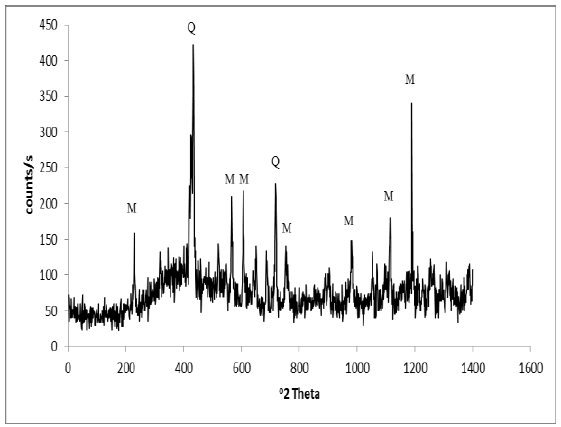
Figure 3. X-ray diffraction of FA.